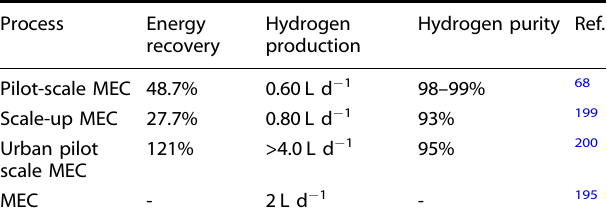
Table 4. A selective review of the studies on bioenergy and biohydrogen production using MEC.